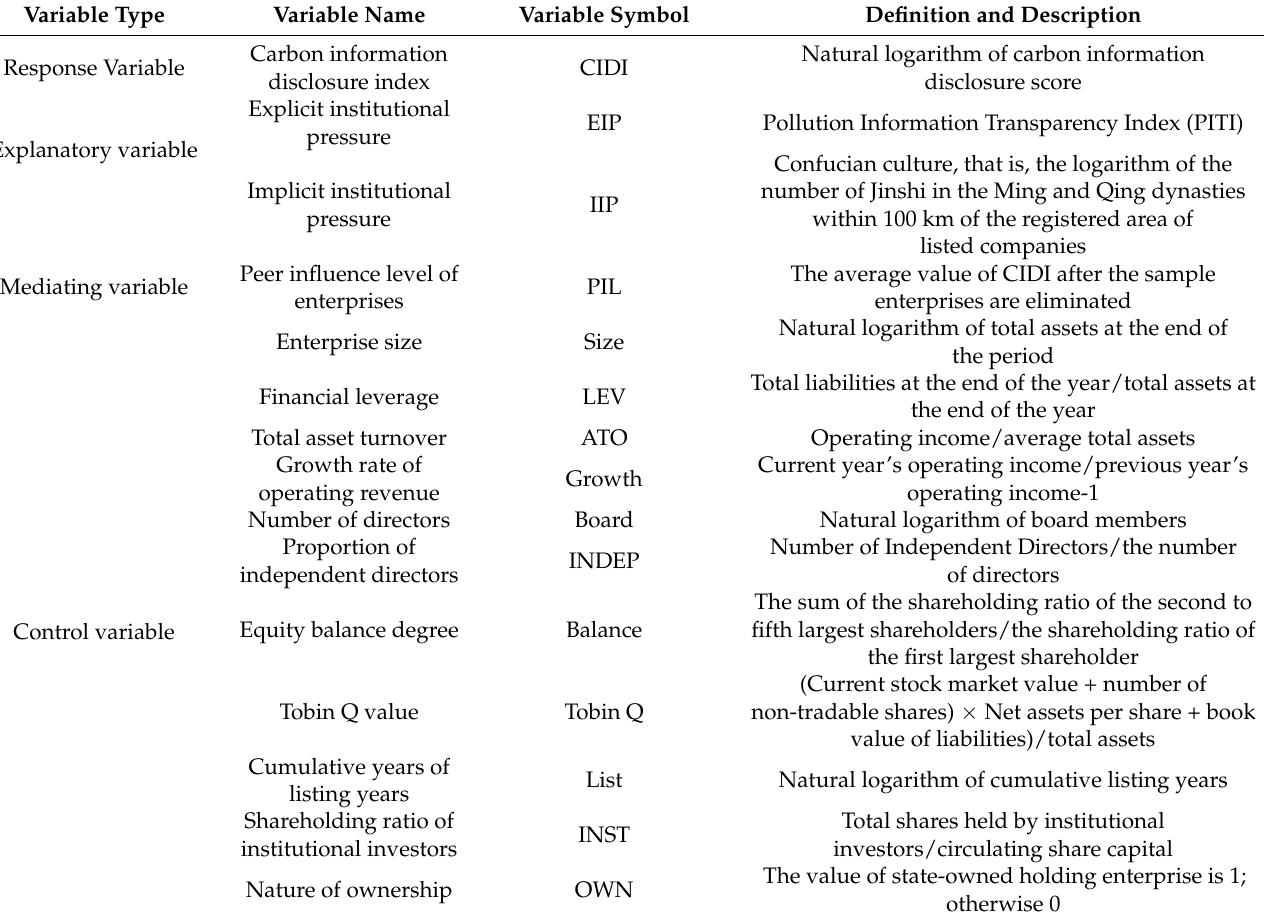
Table 2. Definition of